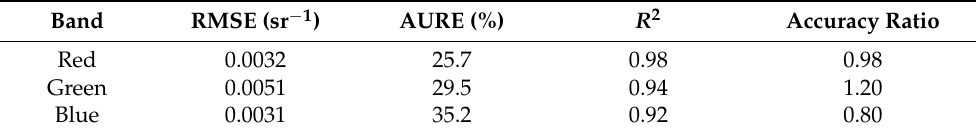
Figure 4. Scatterplots of water reflectance derived from digital images and measured by spectrometer at 112 sampling stations in ( a ) red, ( b ) green, and ( c ) blue bands. Table 4. Retrieval accuracy of water reflectance from 112 sampling–point